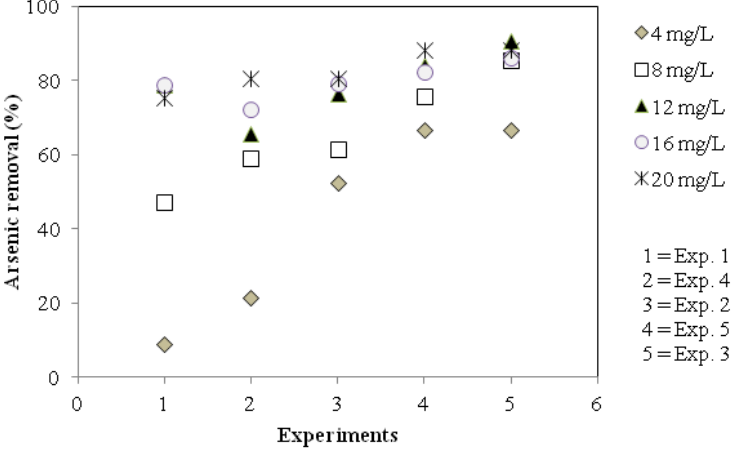
Figure 6. Total arsenic removal percentage for different ferric chloride